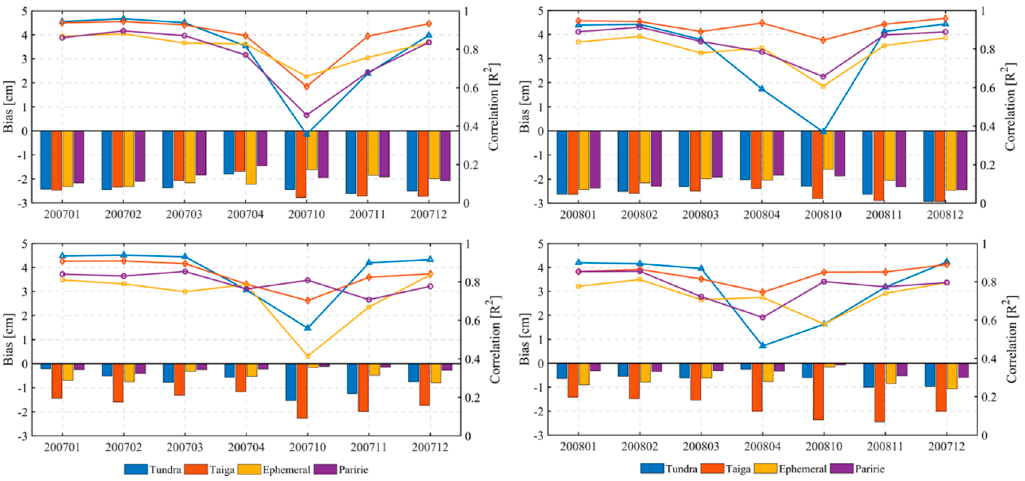
Figure 15. Temporal snow depth bias variations (bars) and R 2 values (point lines) for dual-channel ( top ) and multichannel ( bottom ) algorithms.